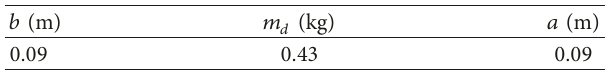
Table 2: Simulation and experimental parameters of the moving platform and the fixed base.